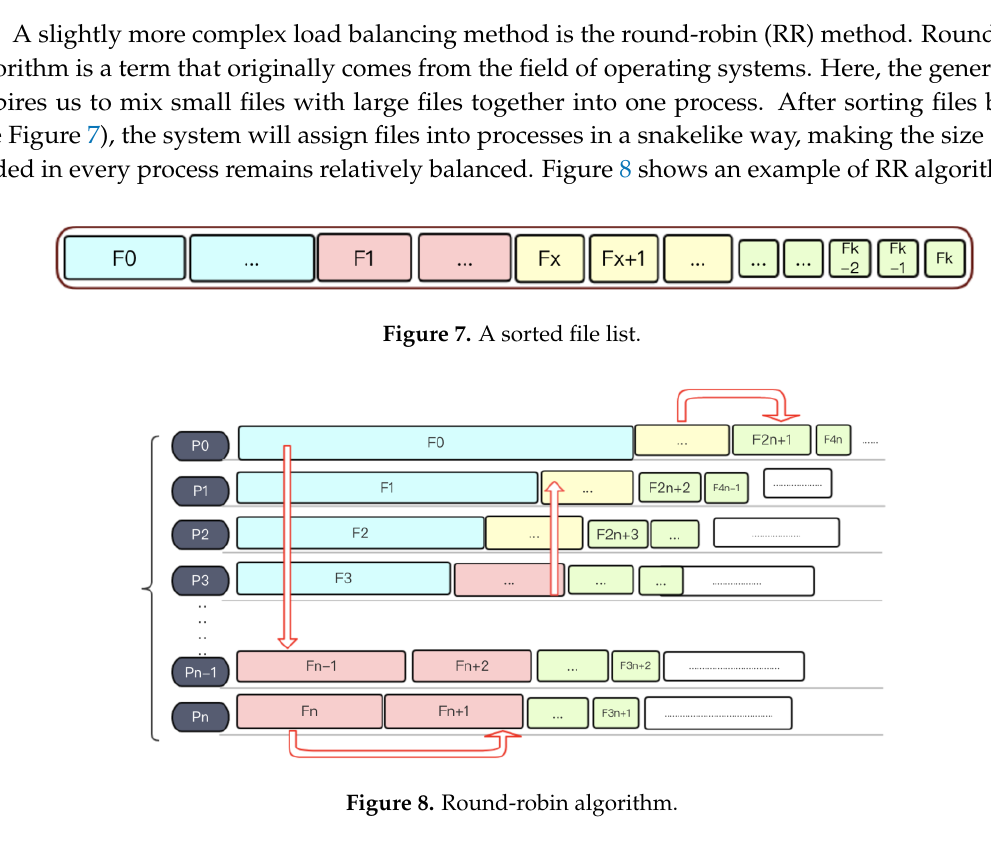
Figure 6. Random load balancing strategy.